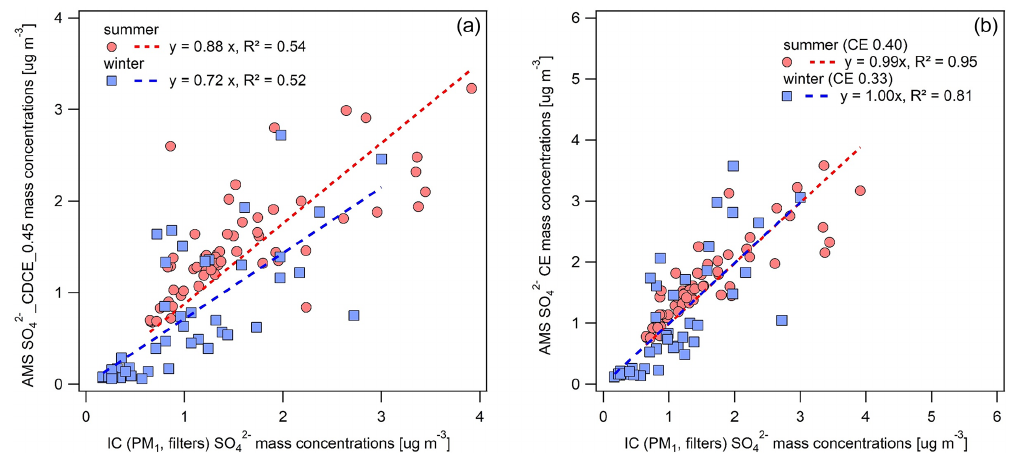
Figure A1. Comparison of sulfate concentrations measured by AMS and retrieved from PM 1 filter analysis by IC with applied CDCE correction (a) and constant CE correction (b) for both measurement seasons.